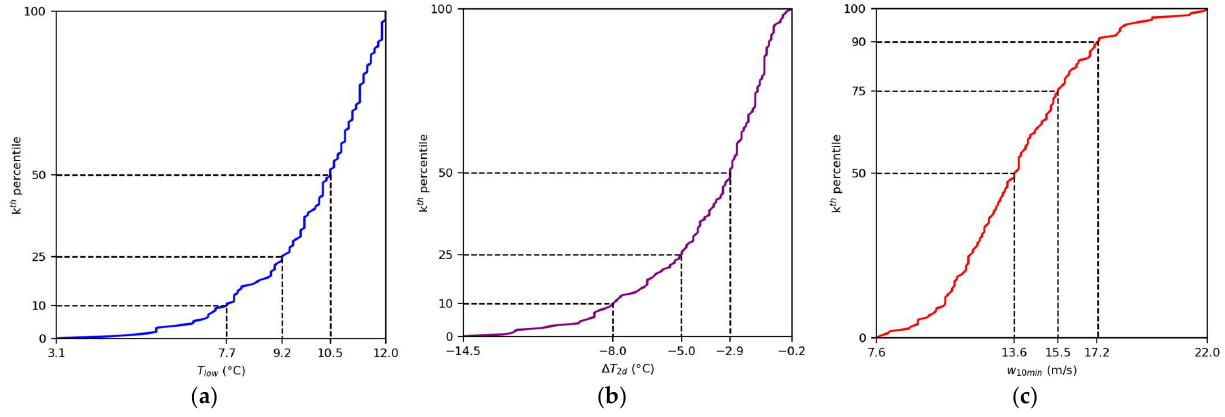
9 Figure 6. Box-and-whiskers diagram of temperature change with n = 1, 2, 3 and 4 of all cold events. Table 4. The 50th, 25th and 10th percentiles of values for n-day temperature change for all cold events (in °C).